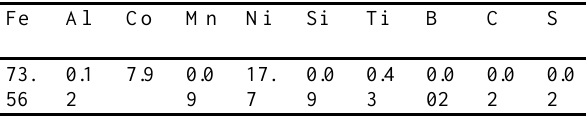
Table 1. Chemical composition of maraging steel (wt%).